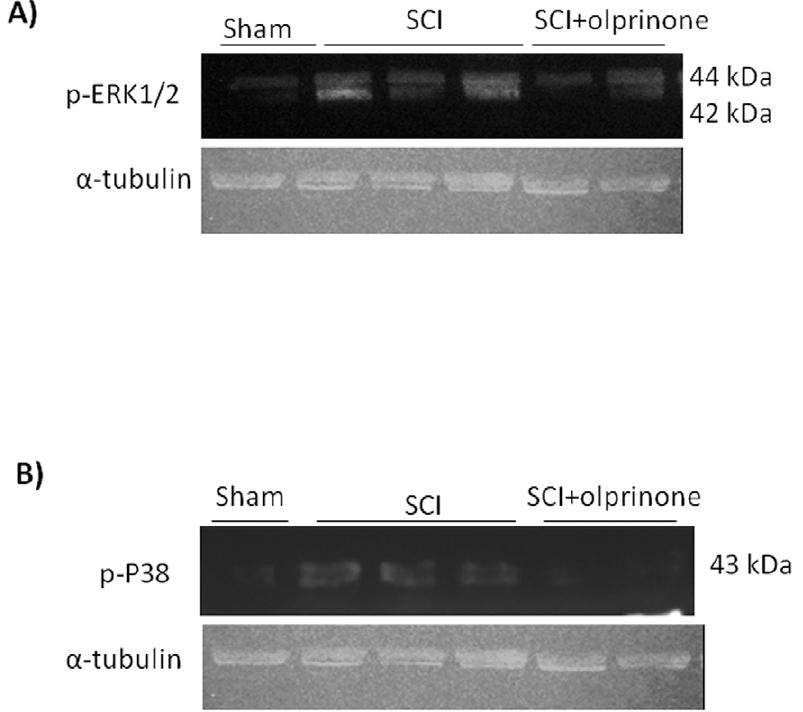
Figure 7. Effect of olprinone on activated kinases. The spinal cord extract were immunoblotted for the dual-phosphorylated form of ERK and for phosphor-P38. pERK1/2 is upregulated in injured mice as compared to sham-operated mice ( A ). Spinal cord levels of pERK1/2 were significantly attenuated in olprinone (0,2 mg/kg)-SCI treated mice in comparison to SCI animals ( A ). Similarly, the treatment with olprinone significantly reduced the SCI-induced increase of the expression of phospho-P38 ( B ).